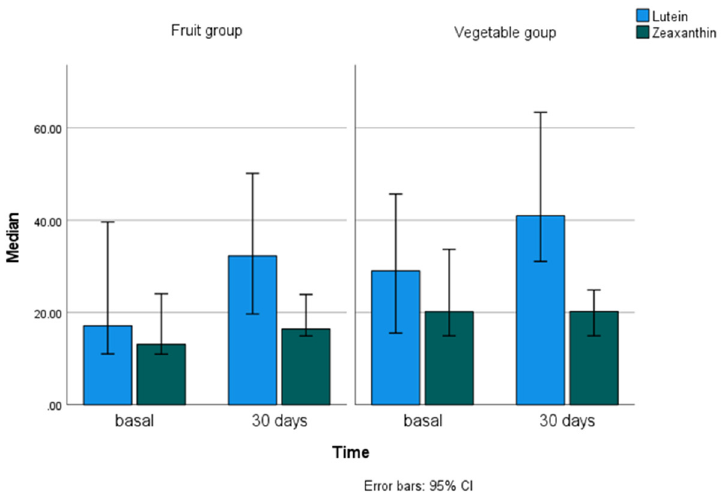
Figure 4. Lutein and zeaxanthin concentrations (µg/g dry weight) in the faeces at the beginning and end of the study in each group. end of the study in each